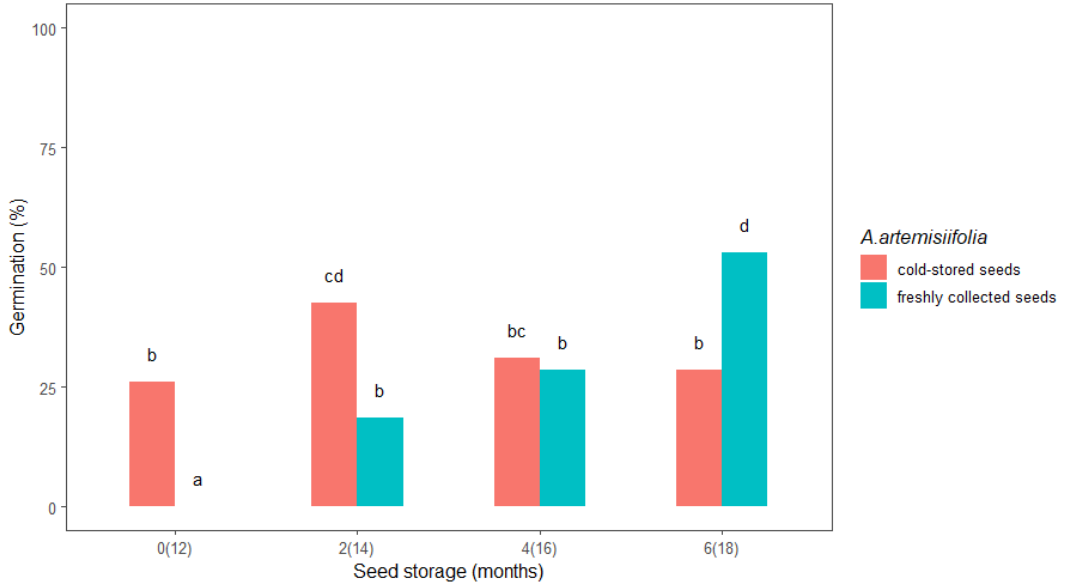
Figure 1. The effect of storage duration on freshly collected and cold-stored Ambrosia artemisiifolia seeds. The estimated marginal means of eight replicates are shown (standard error = 3.1). The means that are labelled with the same letter are not significantly different ( p < 0.05) according to Tukey’s test. Numbers on the x-axis indicate the months of seed storage for the freshly collected seeds and the total months of storage in parentheses for the cold-stored seeds.